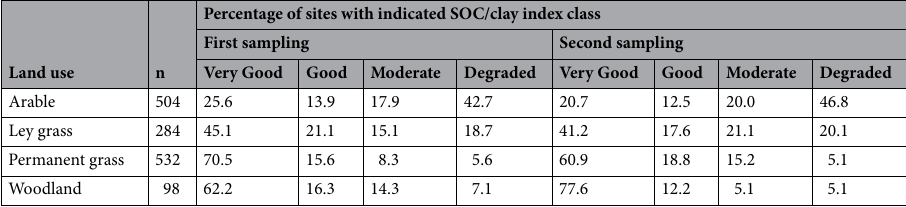
Table 2. Percentages of sites with a given index class under each land use in each sampling.